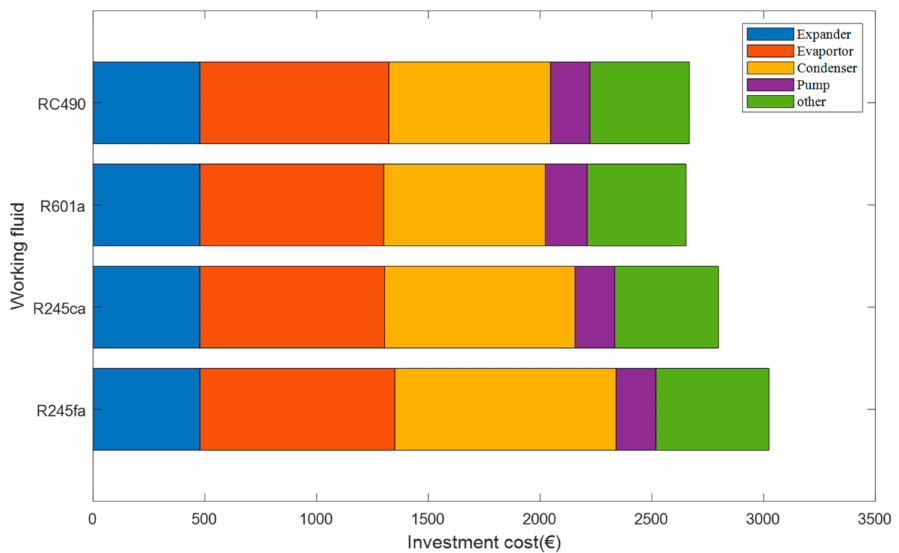
Figure 4. The component costs for ORC using different working fluids.